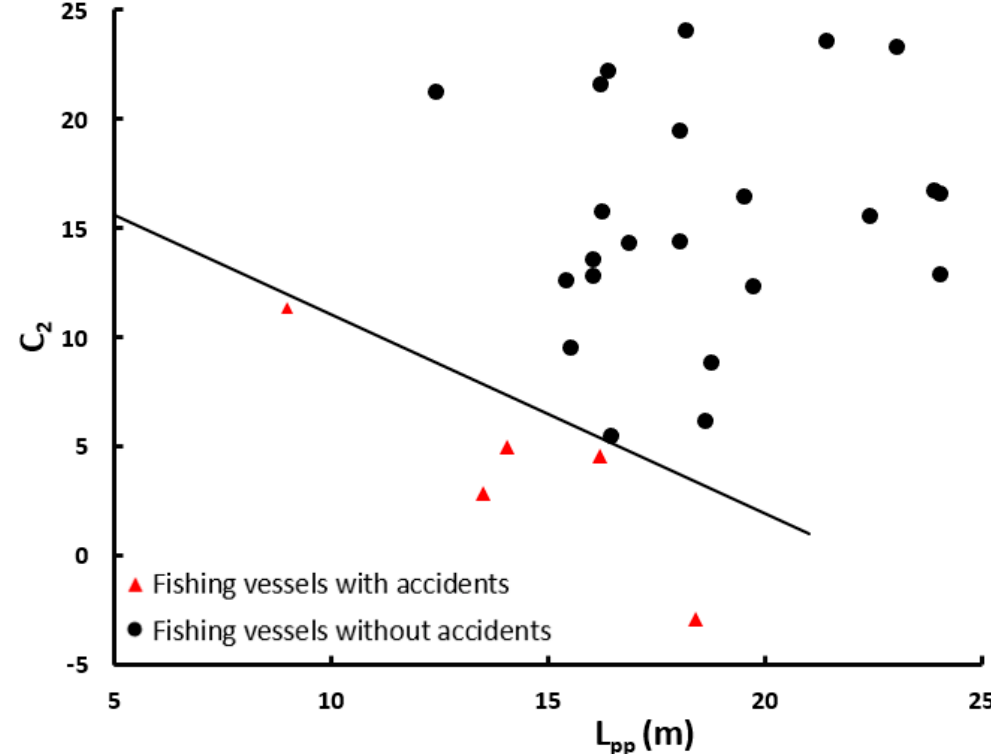
Figure 6. The effect of ship length ( L pp ) over the C 2 coefficients for the analyzed vessels with and without accidents.